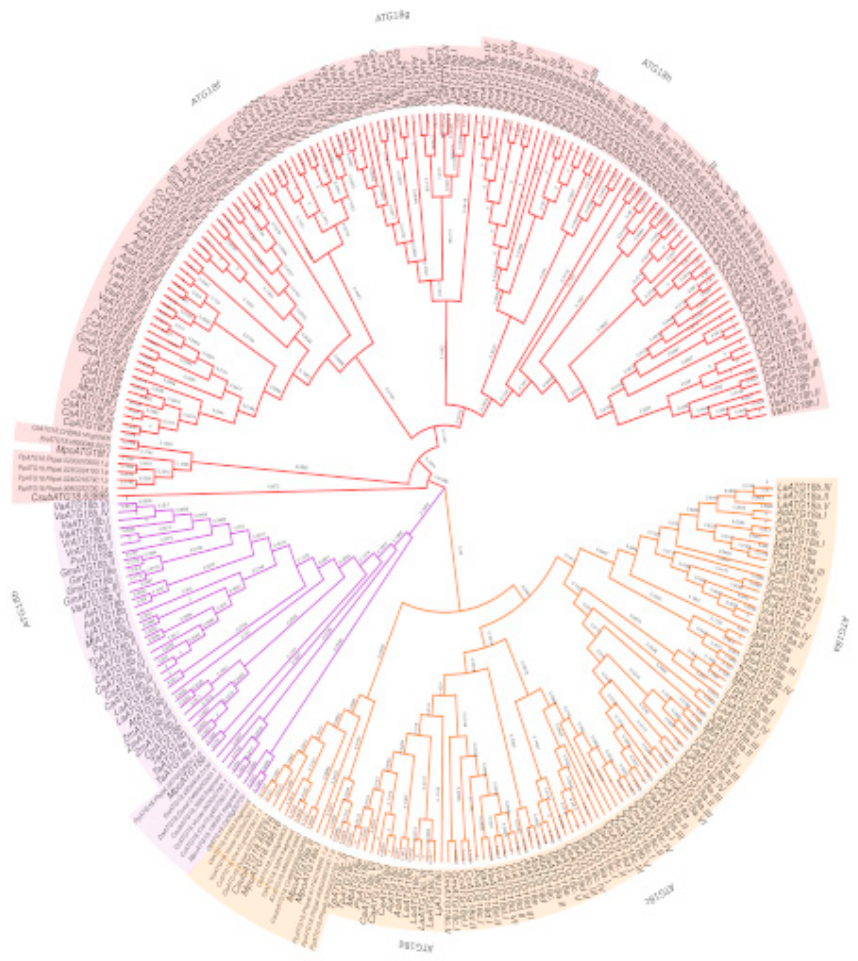
Figure 7. Phylogenetic tree of ATG18 proteins in plants. The protein sequences were aligned using Clustal Omega, and the phylogenetic tree was constructed using the ML method in MEGA X software with 1000 bootstrap replications. A total of 280 sequences of ATG18 are differentiated into subfamilies: Subfamily I (yellow), subfamily II (purple) and subfamily III (red). The plant species are differentiated by letters: A. thaliana ( At ), M. polymorpha (Mpo), O. sativa (Os), Triticum aestivum (Ta) , Zea mays (Zm), Arachis duranensis (Ad), Arachis ipaensis (Ai), Cajanus cajan (Cc), Lotus japonicus (Lj), Cicer arietinum (Ca), Lupinus angustifolius (La), Pisum sativum (Ps), Vigna angularis (Va), Vigna radiata (Vr) and Trifolium pratense (Tp), P. patens, C. braunii (Cb) , C. reinhardtii (Cr) , D. salina (Ds), V. carteri (Vc), K. nitens (Kn) , M. pusilla (Mpu) , O. lucimarinus (Ol) , O. tauri (Ot) and C. subellipsoidea (Cs). The branch lengths are labeled.